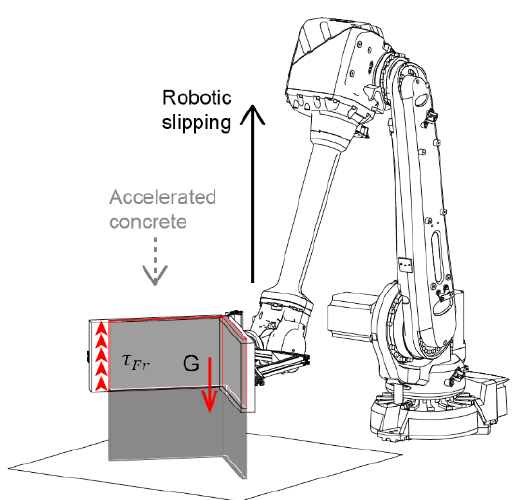
Figure 14. Force balance during slipping with a formwork for producing thin folded structures [11,12].